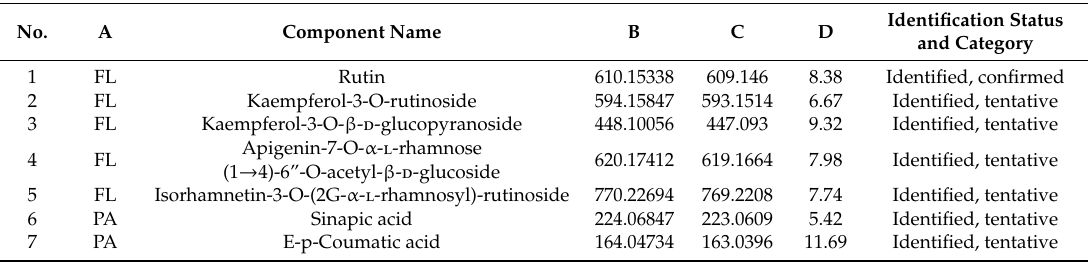
Compounds identified in defatted Pitaya, Hylocereus polyrhizus seed extract using UPLC-QTOF /